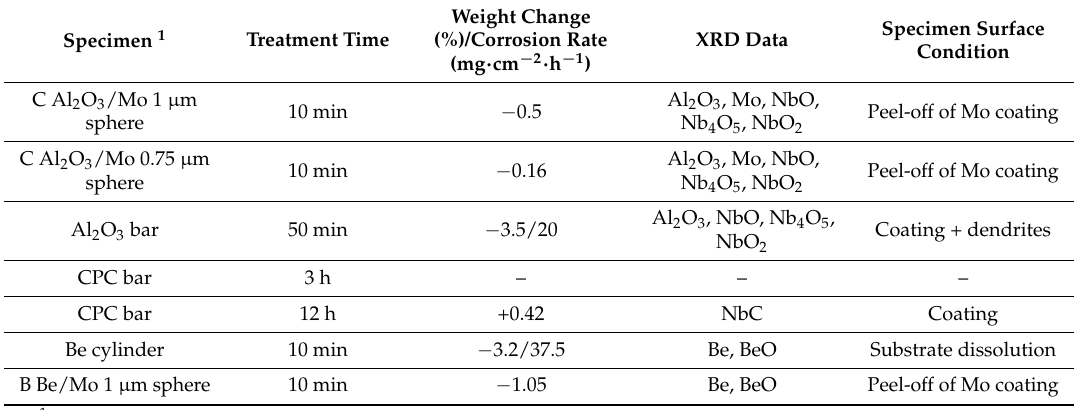
Table 1. Results of corrosion tests of different shapes specimens made of different materials.